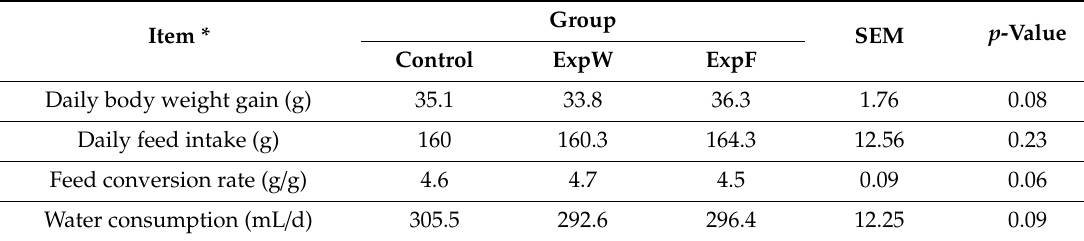
Table 2. Growth performance and water consumption of rabbits.